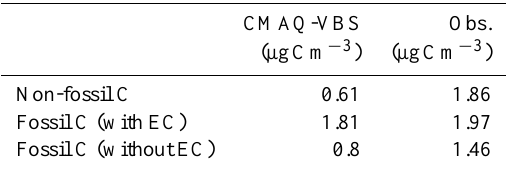
Table 5. Comparisons of CMAQ-VBS non-fossil and fossil C against filter-based measurements ( N =